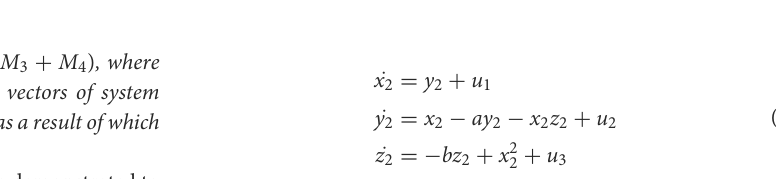
y , y z , and z x plane, which are shown in the 2D phase portrait for the − − −